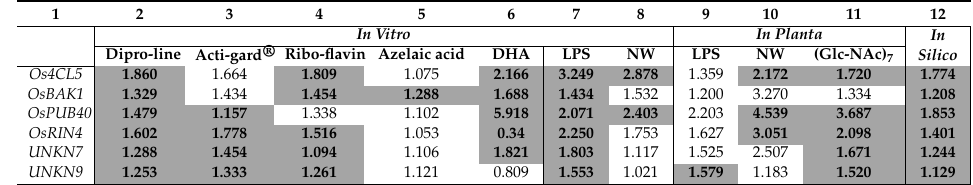
Table 2. Relative expression levels of the screening gene set upon four-hour incubations with five IR-inducing compounds (columns 2–6). Expression levels were determined by RT-qPCR and are expressed relative to mock treated cells. RT-qPCRs were performed with three technical replicates on two biologically independent replicates. As comparison, the relative expression values detected in vitro and in planta upon PAMP treatments are listed in columns 7–8 and 9–11, respectively (shown in Figures 1 and 2, respectively). The upregulations determined in the WGCNA are displayed in column 12. For columns 7–8, the data correspond with the 200 µg LPS/mL and 107 nematode-equivalents/mL treatments, respectively. Grey cells with bold data represent significant differential regulations.